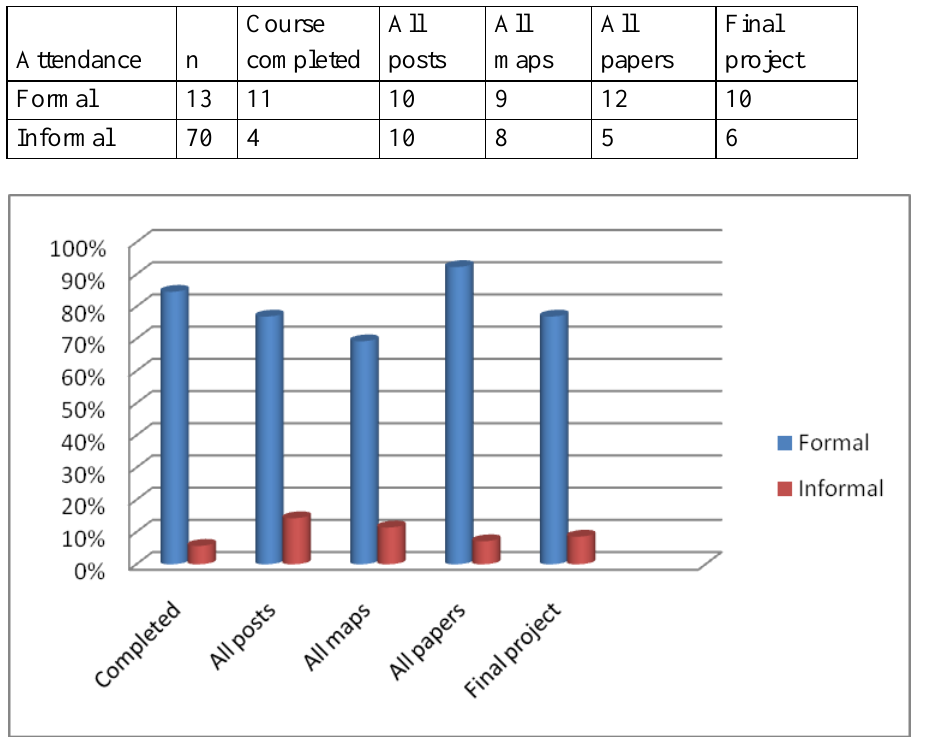
Figure 4 . Completion of the course and assignments by attendance type (in